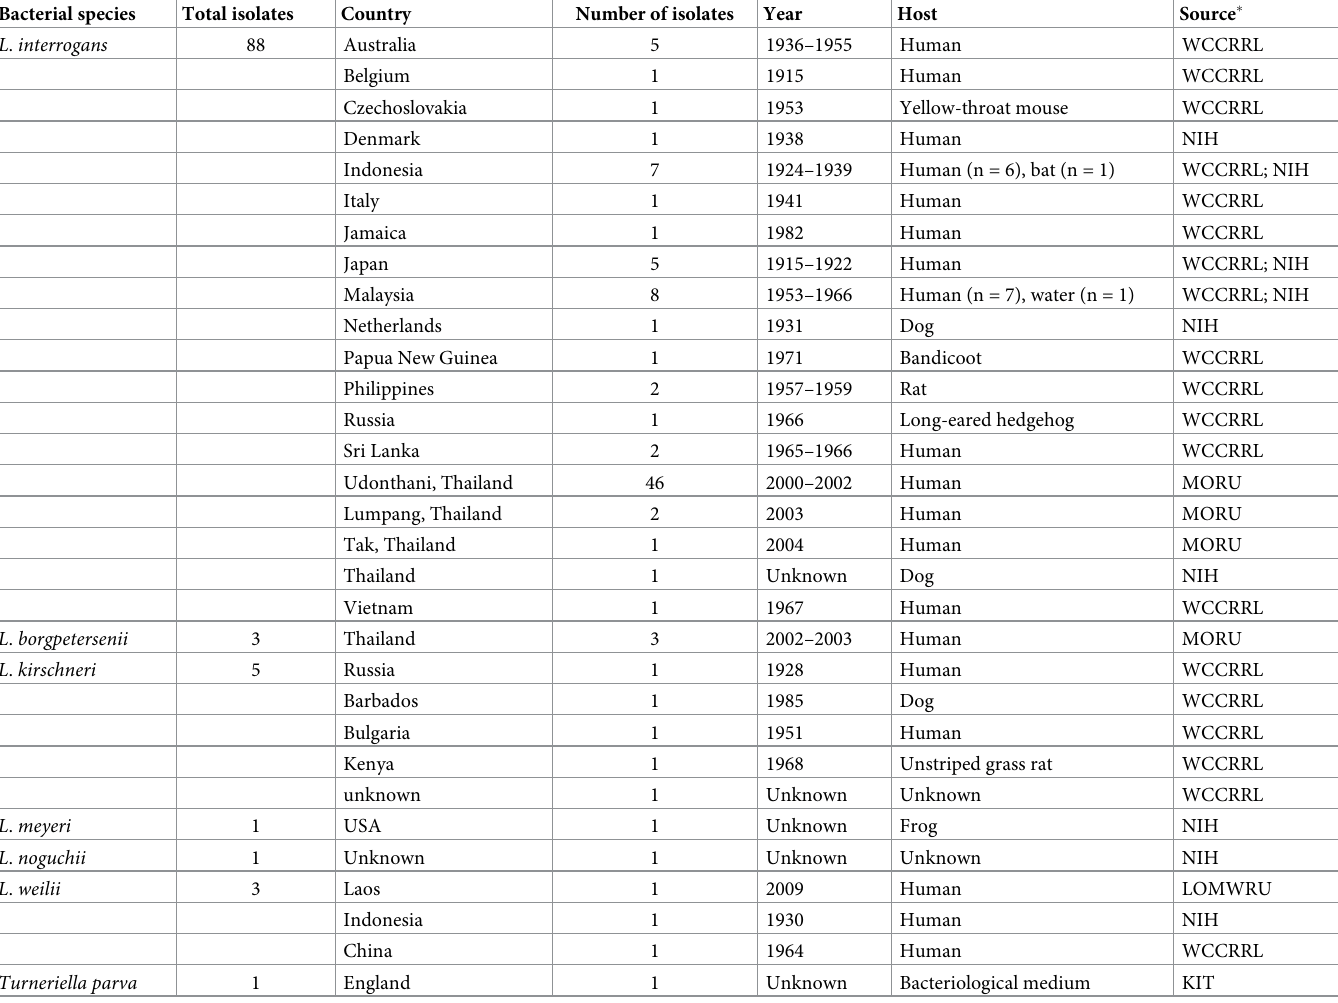
Table 2. List of Leptospira isolates (n = 101) and Turneriella parva used for Leptospira MALDI-TOF MS database. Bacterial species Total